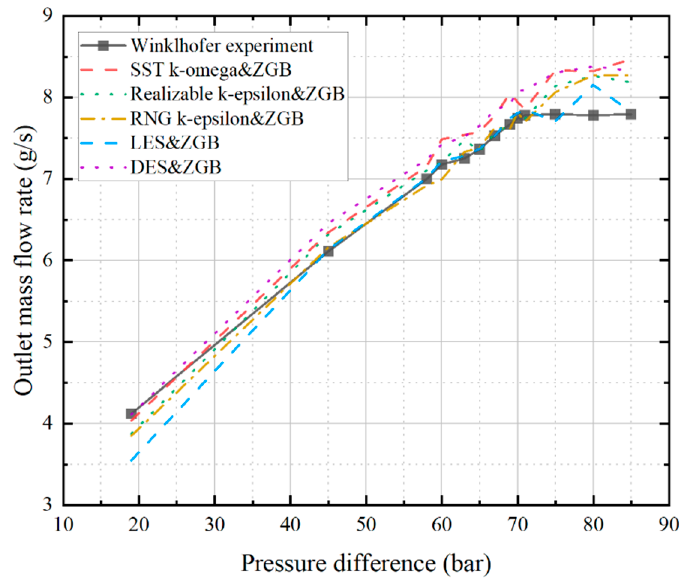
Figure 7. Comparison of mass flow rate results at the exit of microchannels under different turbulence models.